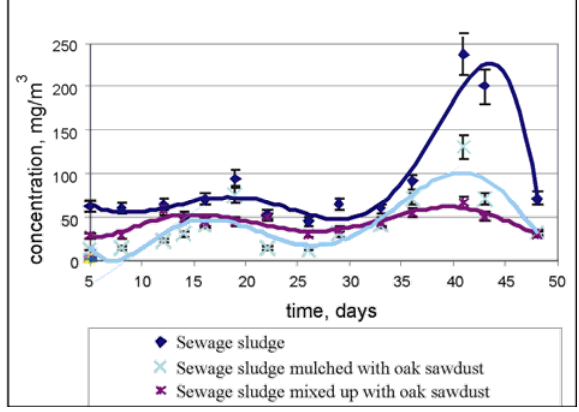
Fig. 5. Ammonia emissions during composting of sewage slud- ge with oak sawdust